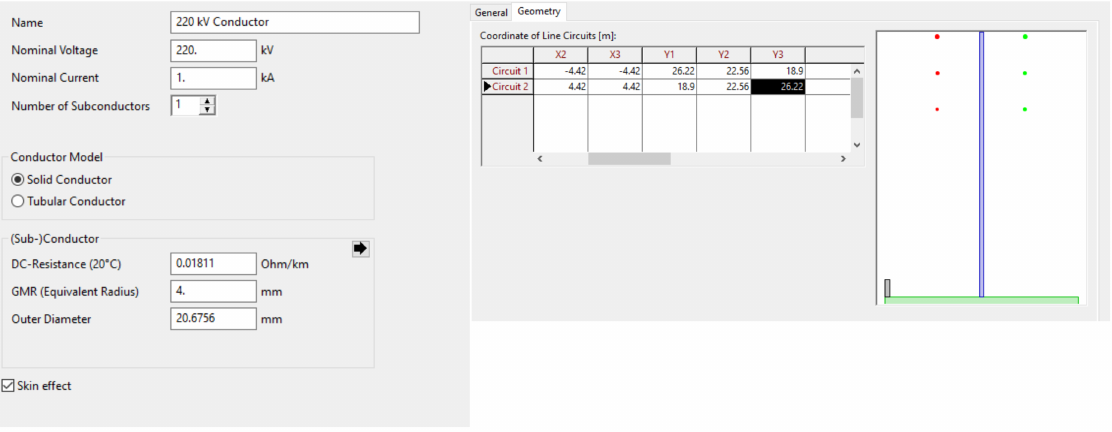
Figure 2. Conductor types and tower geometry of a 220 kV transmission